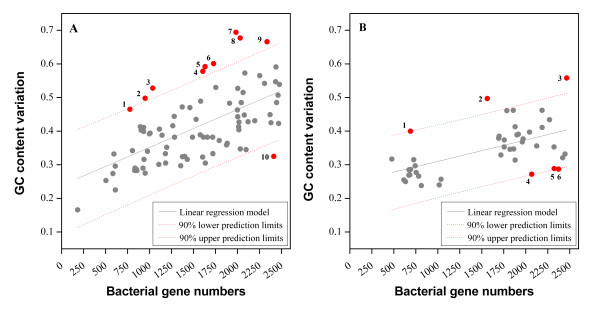
Linear correlation between genome size and GC content. Bacterial genome sizes are represented by the number of genes. Bacteria with less than 2,500 genes were chosen for analysis in dnaE1|polV (A) and dnaE3|polV (B), respectively. There is a strong and significant correlation between genome size and GC content after eliminating outliers (red solid circles). R values change from 0.6179 to 0.7479 (p < 0.0001) in the dnaE1|polV group and from 0.5571 to 0.8172 (p < 0.0001) in the dnaE3|polV group. The linear model is Y = 0.0001128X + 0.2387 for the dnaE1|polV group and Y = 0.00006374X + 0.2464 for the dnaE3|polV group. 90% upper and lower prediction limits are also shown. All the numbered outliers were further analyzed to interpret potential reasons underlying this correlation (Table 6).